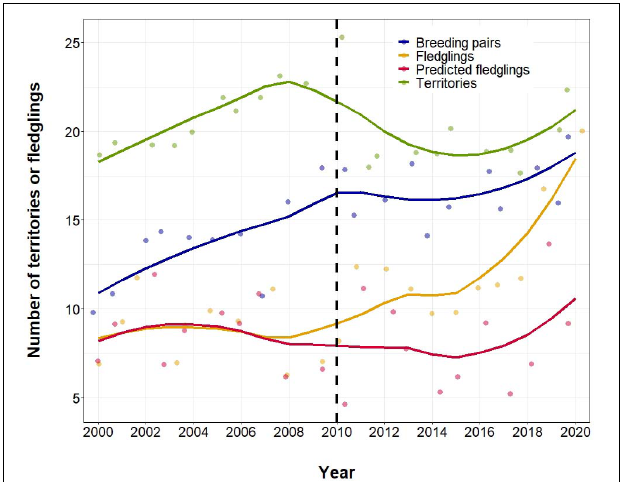
FIGURE 2 | Inter-annual variation in the number of territories (i.e., territorial pairs showing breeding behavior), breeding pairs (i.e., pairs that lay at least one egg), number of fledglings successfully raised and the predicted number of fledglings that would have been produced without adaptative management. The vertical line shows the beginning of the management actions (2010). Colored dots represent raw data points. The lines showed the smoothed conditional means by using “loess” method in the package